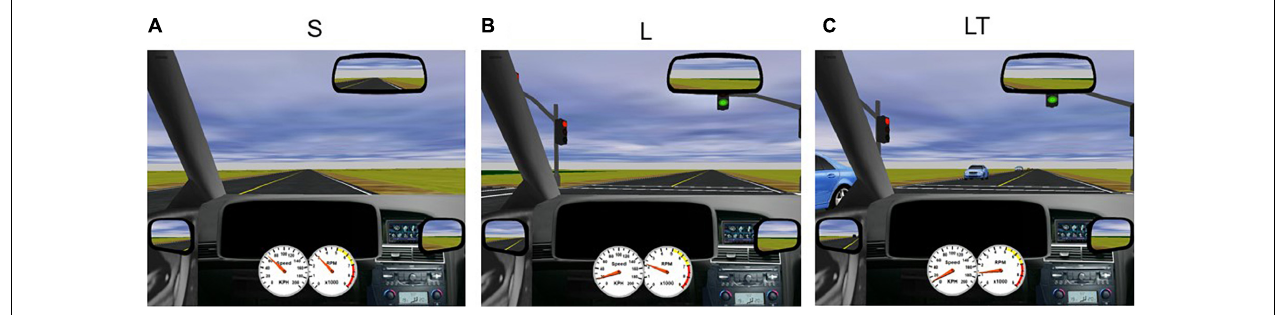
FIGURE 1 | Screenshots of STISIM driving scenarios. (A) S, straight driving; (B) L, left turn at an intersection without traffic; and (C) LT, left turn with